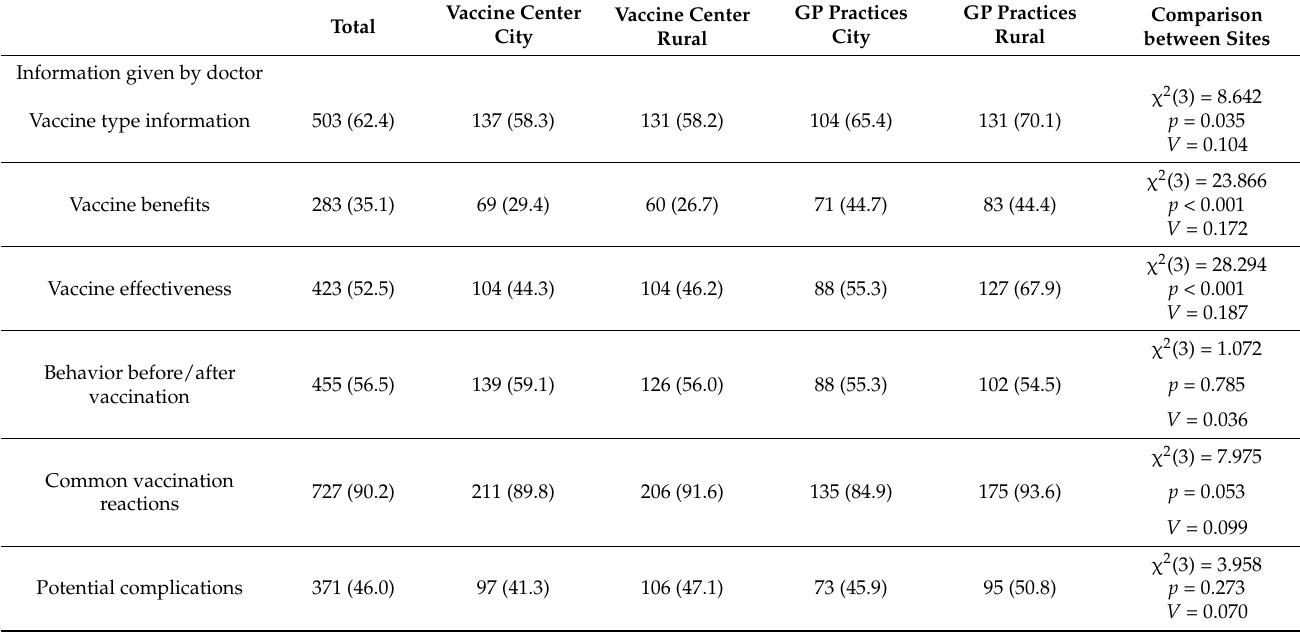
Table 3. Provision of vaccination information and comparison between vaccine